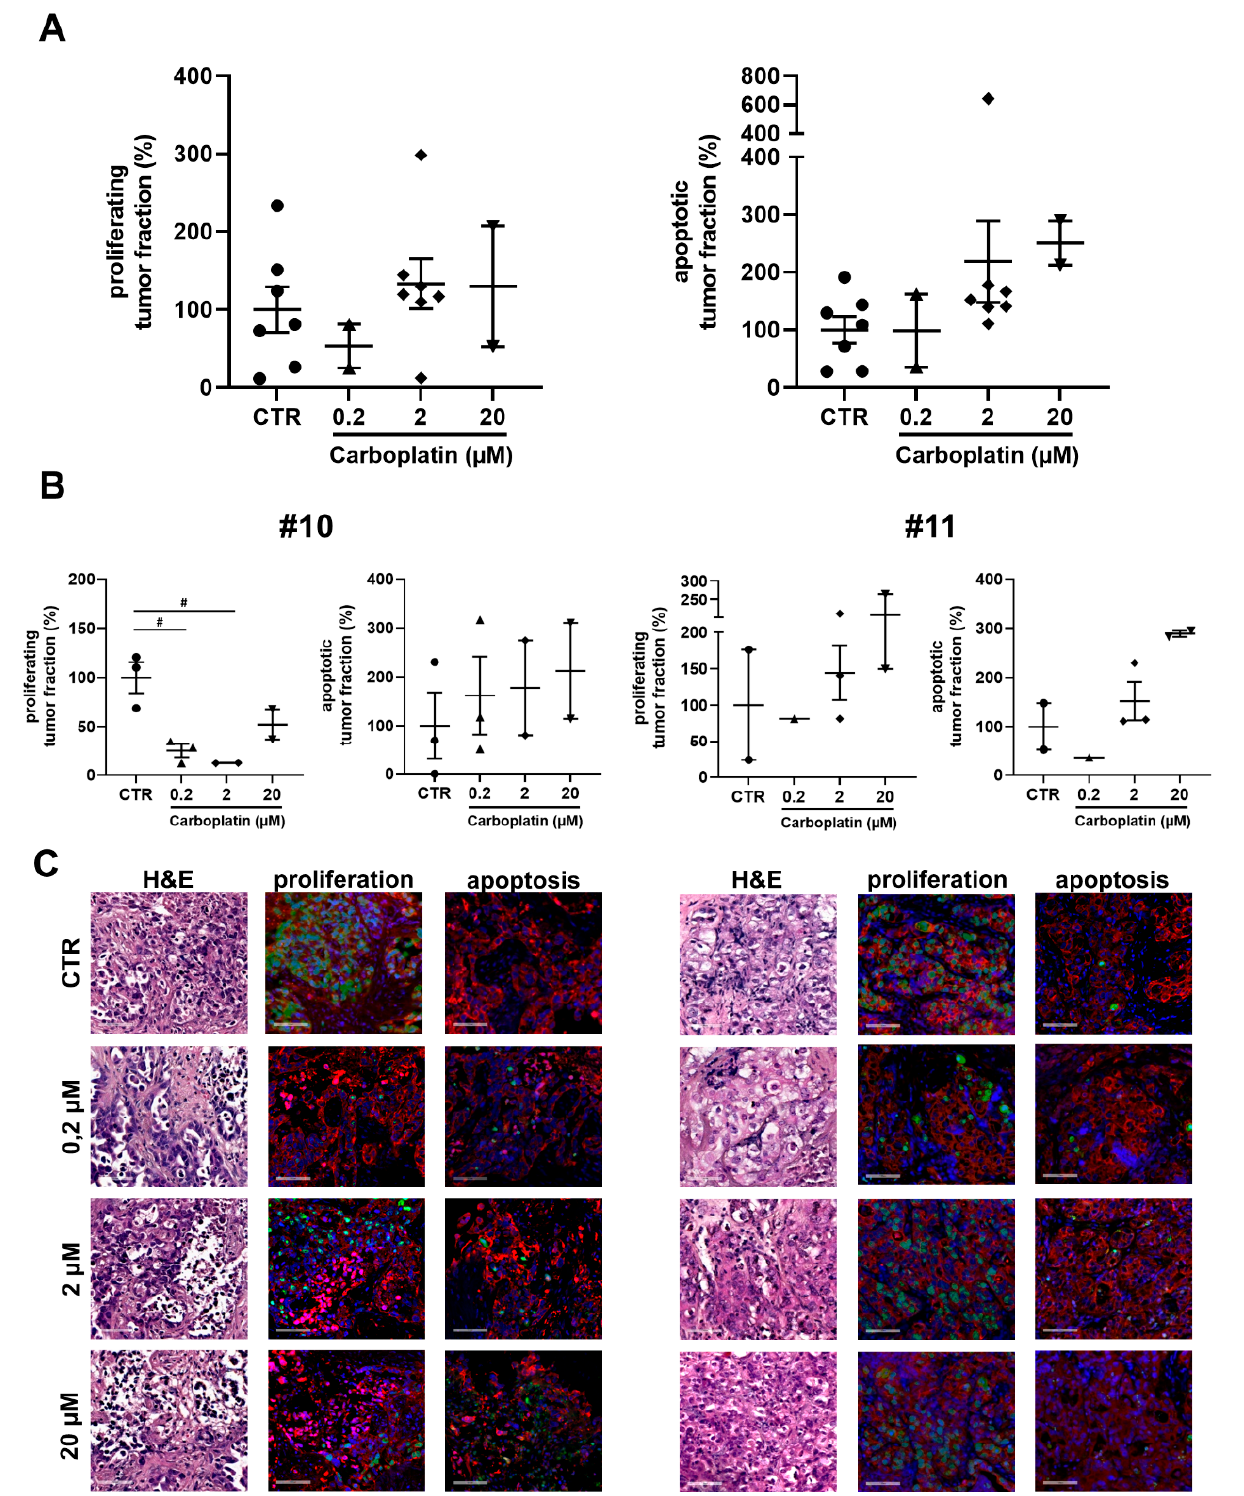
Figure 2. Dose-dependent responses with carboplatin treatment. ( A ) Effect of carboplatin on tumor proliferation and apoptosis. Tissue was treated with 0.2, 2 or 20 µM of carboplatin for 72 h after 24 h from the start of cultivation ( n = 7 for CTR and 2 µM, n = 2 for 0.2 and 20 µM). Error bars represent SEM. ( B ) Individual response of #10 and #11 to carboplatin determined by tumor proliferation and apoptosis. Error bars represent SEM. ( C ) Representative images of #10 and #11. Tissue was stained with antibodies against Ki67 and cleaved-PARP. Bar = 100 µm. Blue = Hoechst, red = panCK, green = Ki67 in proliferation/cPARP in apoptosis. # p < 0.01 (One-way ANOVA).